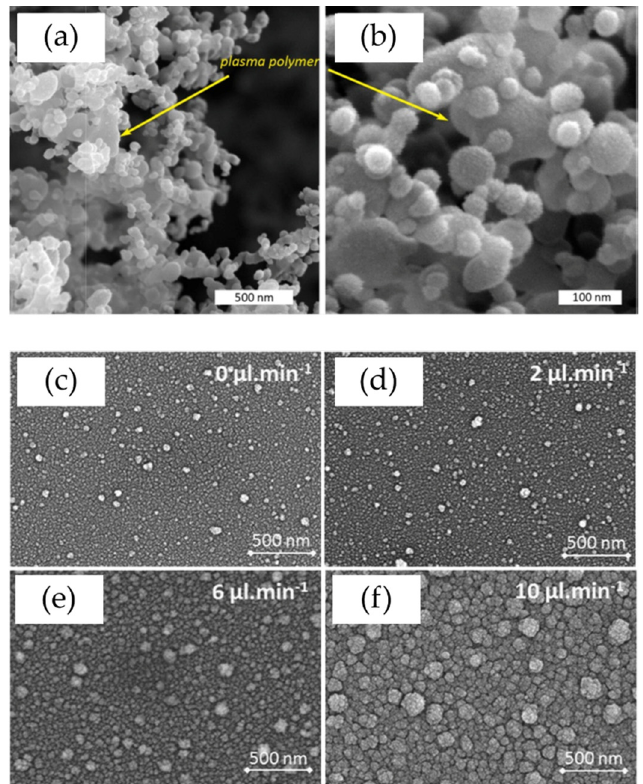
Figure 3. Scanning electron microscopy (SEM) images of different nanocomposite films deposited by AP plasma from conventional single-source or double-source precursors. ( a , b ) NC film consisting of inorganic nitrogen-doped TiO 2 NPs wrapped by a nitrogen-rich plasma polymer deposited by direct PECVD using a DBD fed with nitrogen and vapors of titanium tetraisopropoxide (TTIP). Reproduced with permission from [106]. ( c – f ) NC films consisting of crystalline TiO 2 NPs embedded into a SiO 2 matrix deposited by using an arc-jet fed with nitrogen and the aerosols of TTIP and hexamethyldisiloxane (HMDSO). SEM images refer to the NC coatings deposited by increasing the HMDSO delivery rate from 0 to 10 μ L·min − 1 and keeping constant the TTIP delivery rate (6 μ L·min − 1 ). Reproduced with permission from [66].